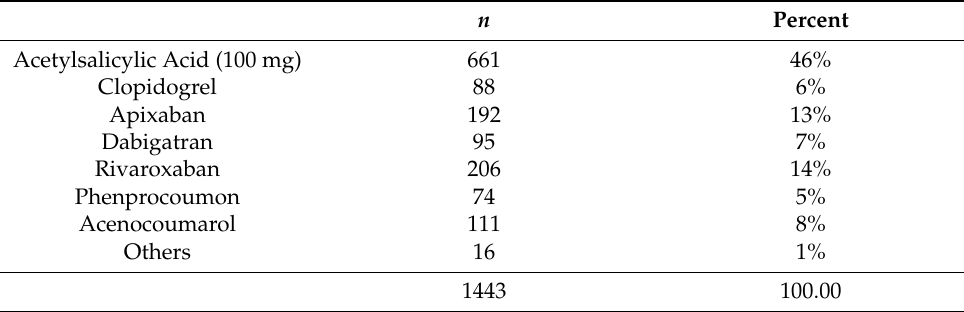
Table 5. ACAPs taken by patients admitted to in-hospital stay due to mTBI.